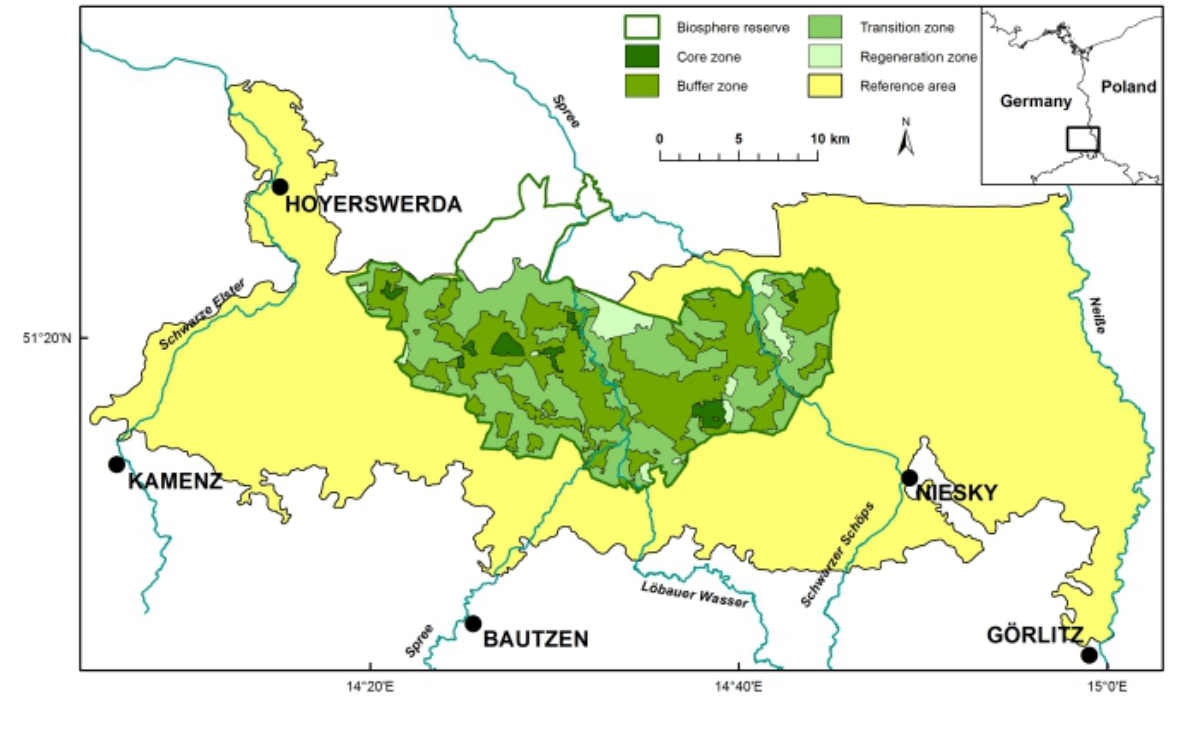
Fig. 1 . Position and zoning of the study and reference area. The border of the complete biosphere reserve is outlined in dark